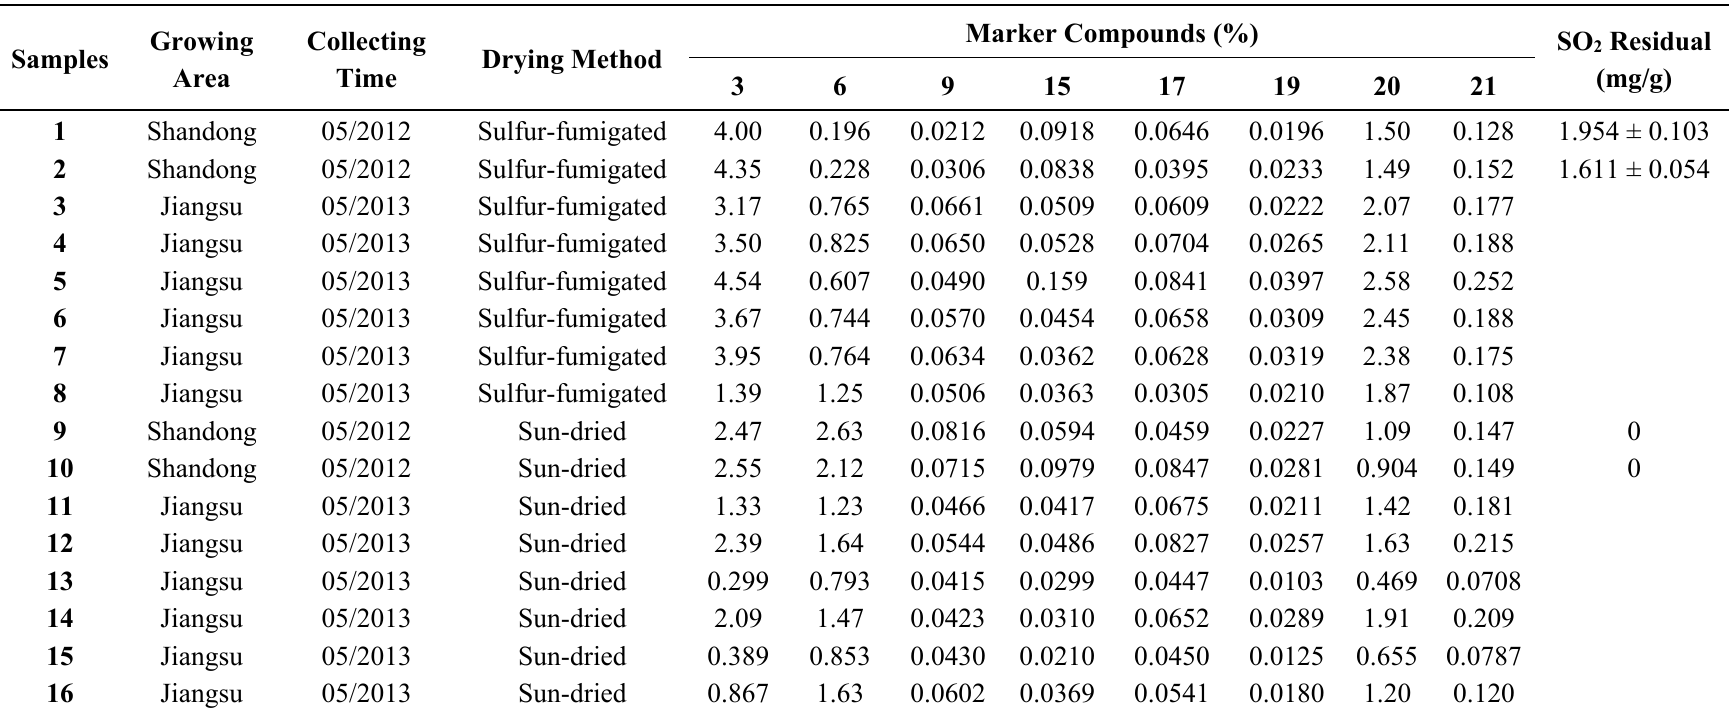
Table 2. The contents of marker compounds and SO 2 residual in the sulfur-fumigated and sun-dried LJF